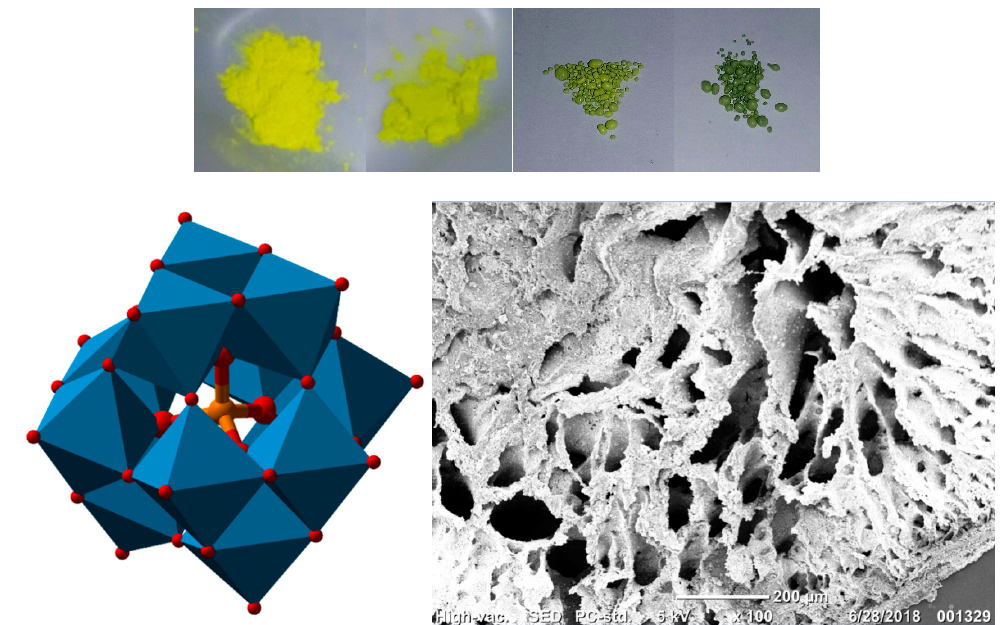
Figure 1. Top: The observed colour changes of ammonium phosphomolybdate (AMP) powder (left two images) and AMP-polyacrylonitrile (PAN) beads (right two images) upon 100 kGy γ irradiation. Below, left: Keggin structure of the phosphomolybdate anion (PMo 12 O 403- ). MoO 6 octahedra: blue; P: orange; O: red [22]. Open source image: Wikimedia commons; right: SEM micrograph of bisected virgin AMP-PAN bead.